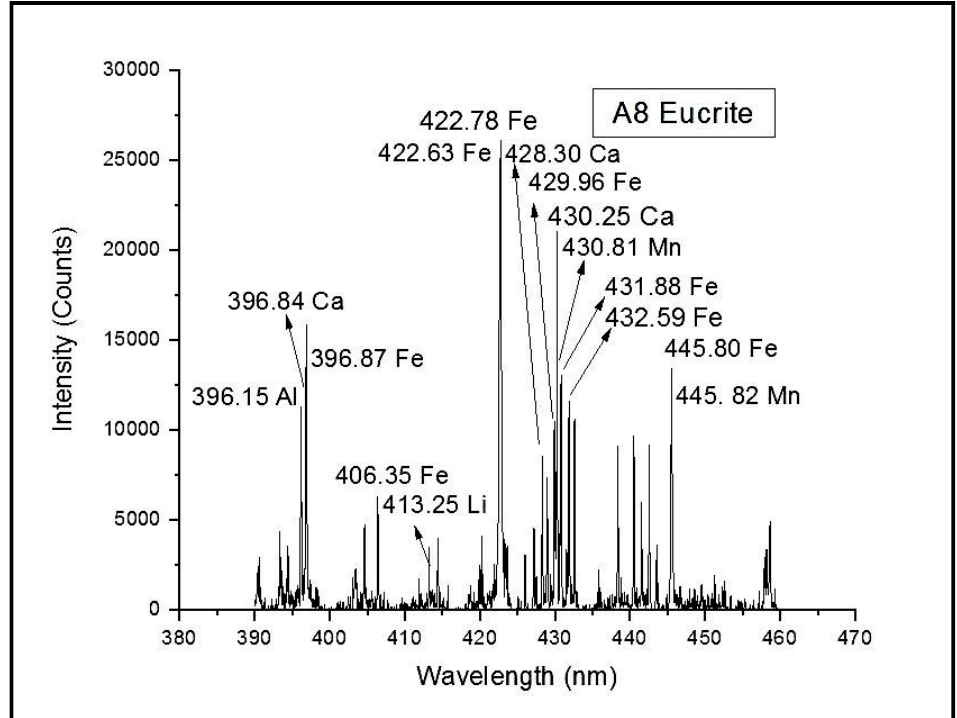
Figure 10. LIBS spectrum of Samples A8 using echelle spectrograph. Reproduced from [28], with the permission of SPIE.